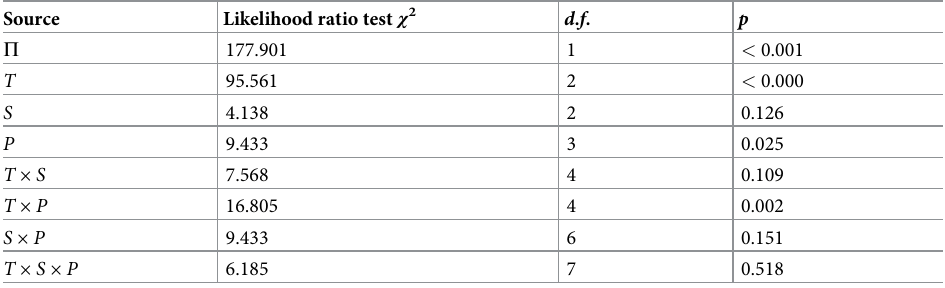
P , grand mean nucleotide diversity; T , transmission mode; S , virus strain; P , evolutionary passage; d . f ., degrees of